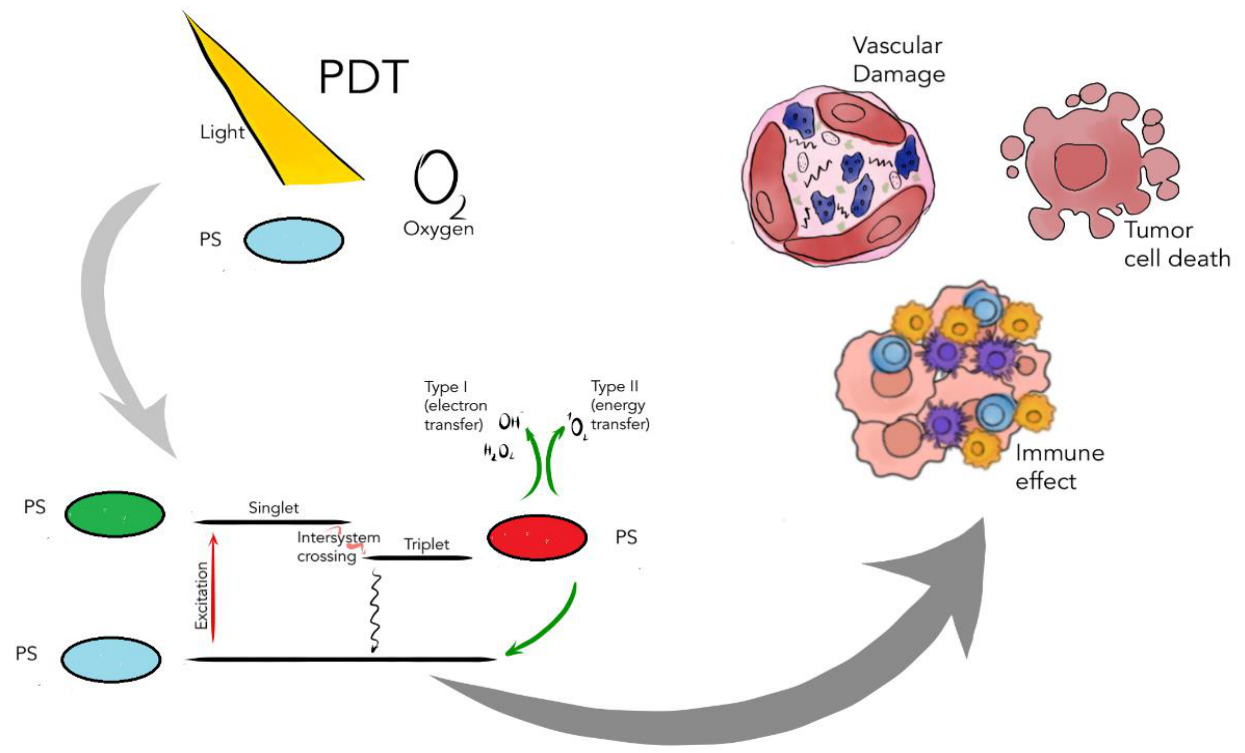
Figure 1. Mechanisms of action of PDT such as inducing immune responses, damaging vascular structures and direct killing of tumor cells. PS’s generate ROS only after exposure to specific light and light activation in the presence of oxygen. Generated ROS mainly cause effector functions (e.g., killing cancer cells, inducing immune responses, damaging vascular structures and direct killing of tumor cells). Following light absorption, the PS reaches an excited singlet state. After an intersystem crossing, the PS, now in a triplet excited state, can react in two ways: react with biomolecules through a hydrogen atom (electron) transfer to form radicals, which react with molecular oxygen to generate ROS (Type I reaction), or the PS in its triplet state can react directly with oxygen through energy transfer, generating singlet oxygen (Type II reaction).